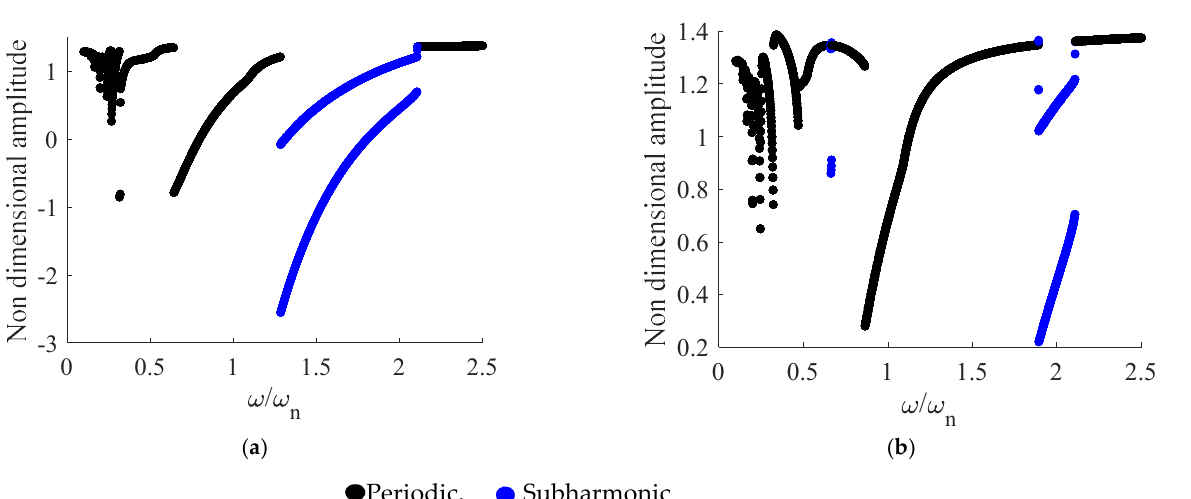
Figure 6. Bifurcation diagram based on ( a ) backward and ( b ) forward simulations, case 2.